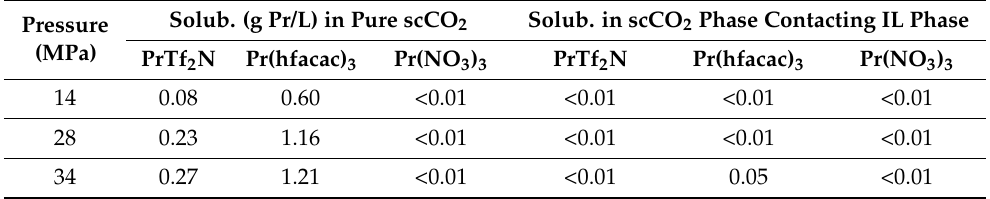
Table 2. Results from the solubility (solub.) studies of Pr salts in neat scCO 2 and in the scCO 2 phase in contact with the IL phase containing the metal salt at 308 K and three pressures.